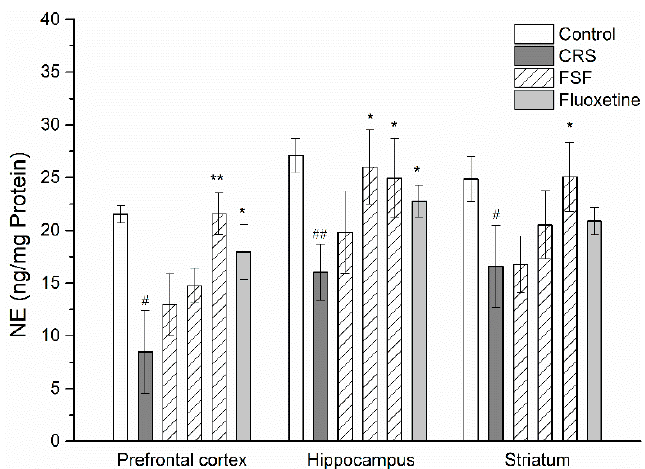
Figure 6. Effects of FSF on NE level in the prefrontal cortex, hippocampus and striatum in mice. n = 6, # p < 0.05, ## p < 0.01, vs. control group; * p < 0.05, ** p < 0.01, vs. CRS group.